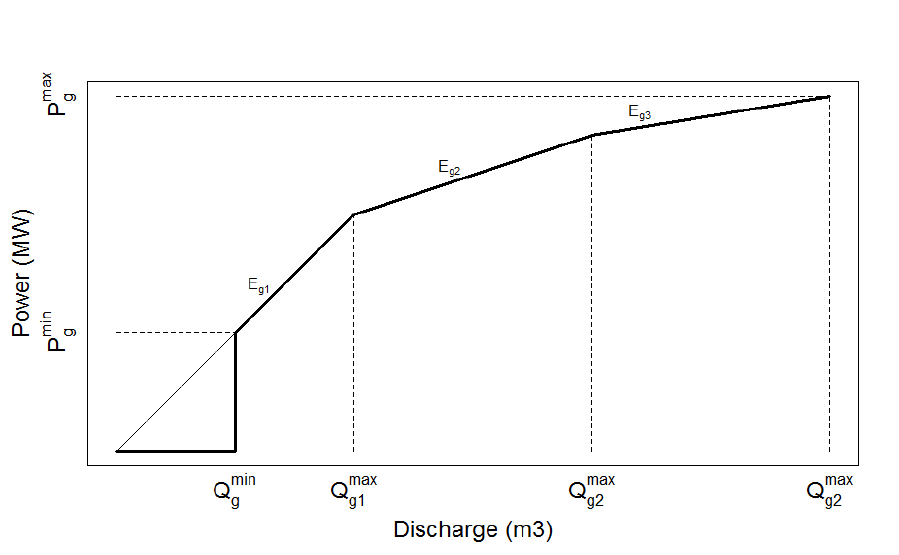
Figure 1. An example of a production function for a generator with three segments. In the mixed-integer program (MILP) formulation, production needs to follow the thick black line, and can either be 0 or above minimum generation. Above minimum generation, production is free to vary over all segments up to P max . In the linearized formulation, production is allowed to follow the thin line between P min and 0, which corresponds to a fractional